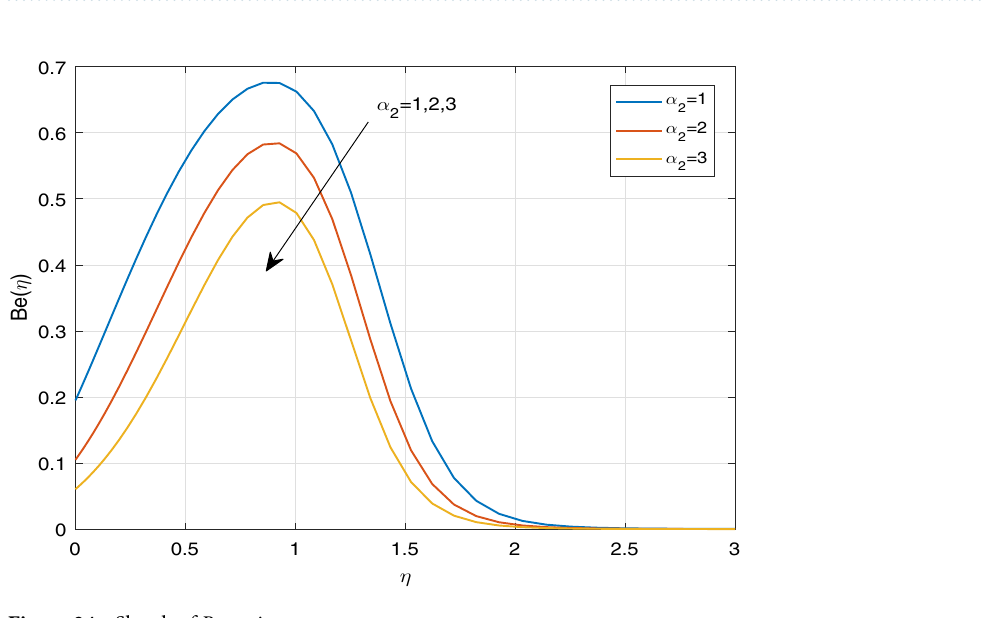
Figure 24. Sketch of Be against α 2